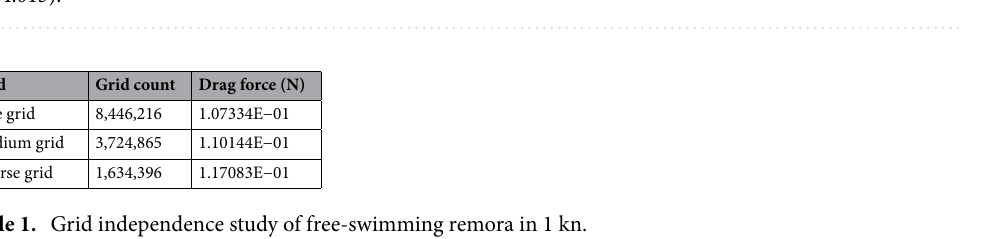
Figure 6. Mesh view for free-swimming simulations (Created using Simcenter STAR-CCM + 2019.2.1 Build 14.04.013).